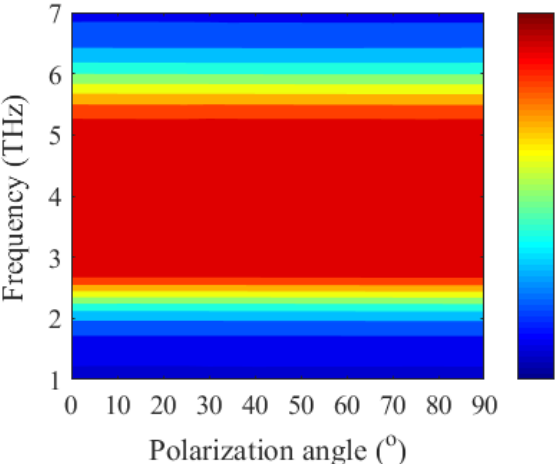
Figure 9. Absorption spectra of the absorber at various polarization angles.